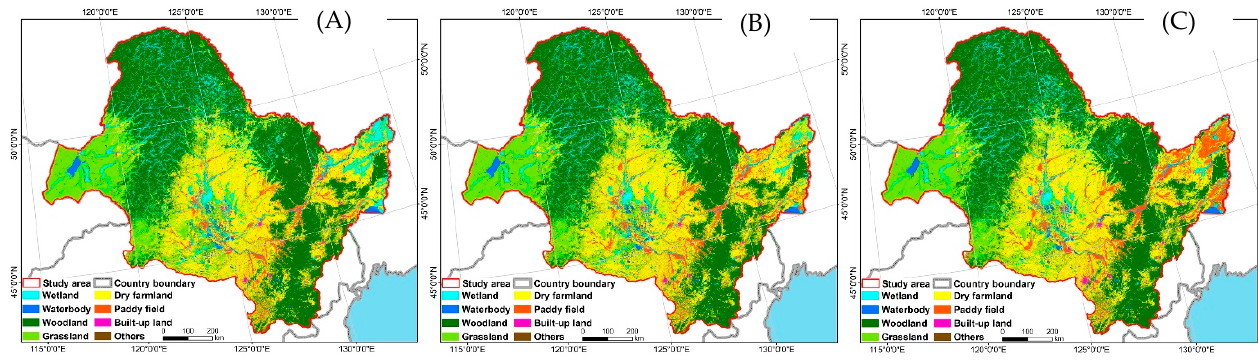
Figure 7. Spatial pattern of land covers of the CARB in 1990 ( A ), 2000 ( B ), and 2010 ( C ).